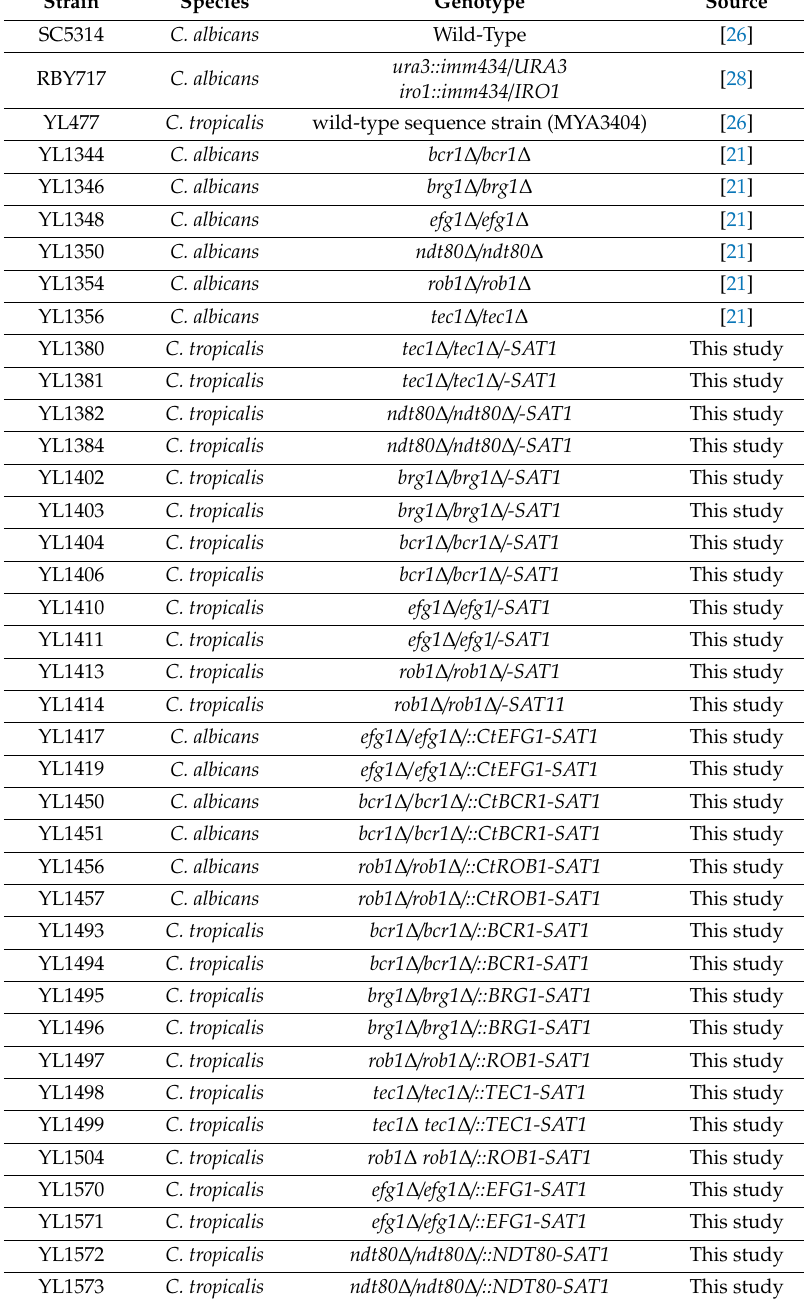
Table 1. Strains used in this